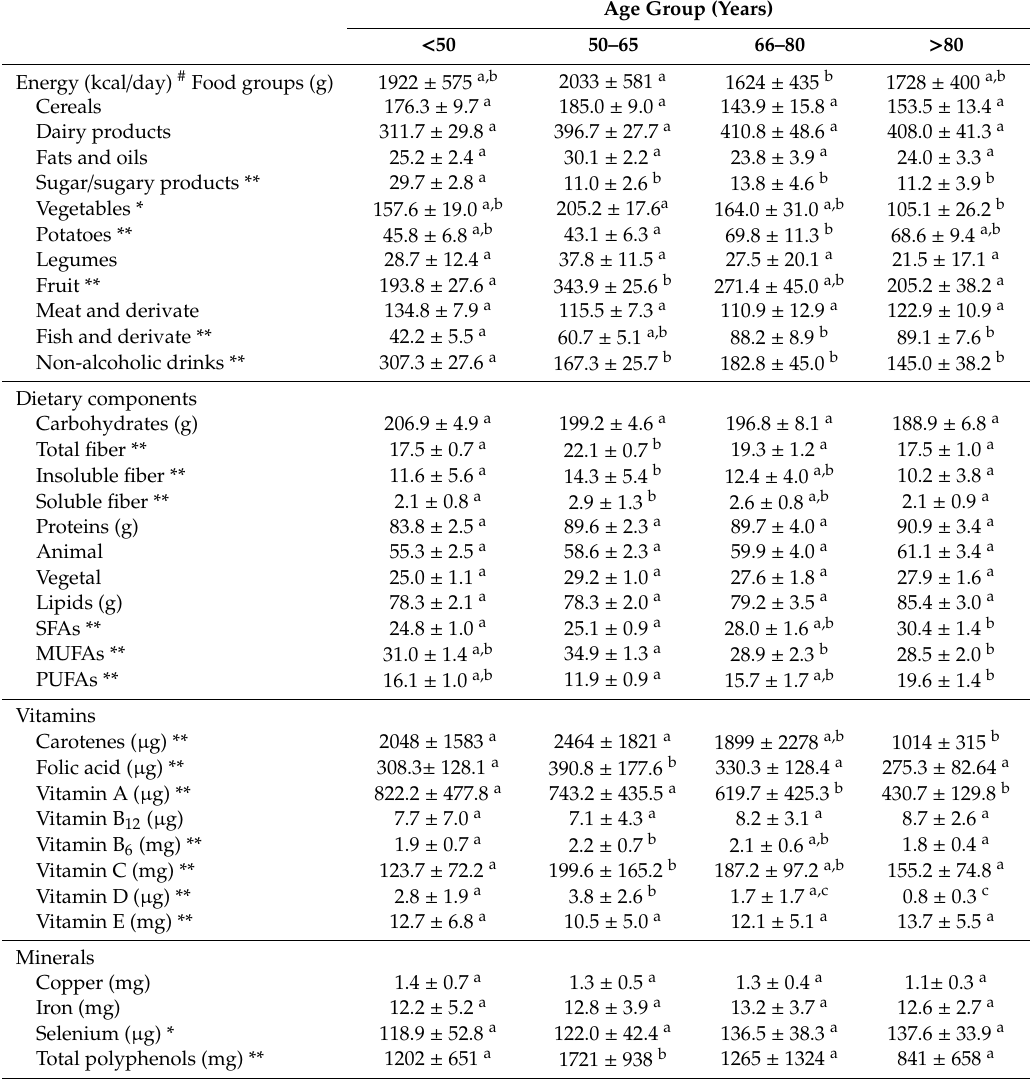
Table 3. Mean daily intake of the major food categories and nutritional compounds related with immune function, according to